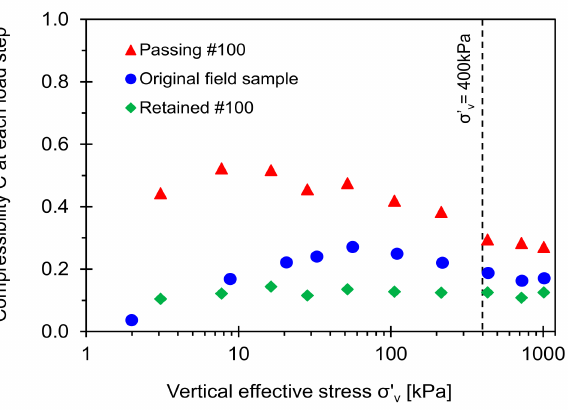
Figure 10. Compressibility for Savannah River sand estimated at consecutive loading steps versus vertical effective stress (note: Sampling depth is 19.20 m–19.35